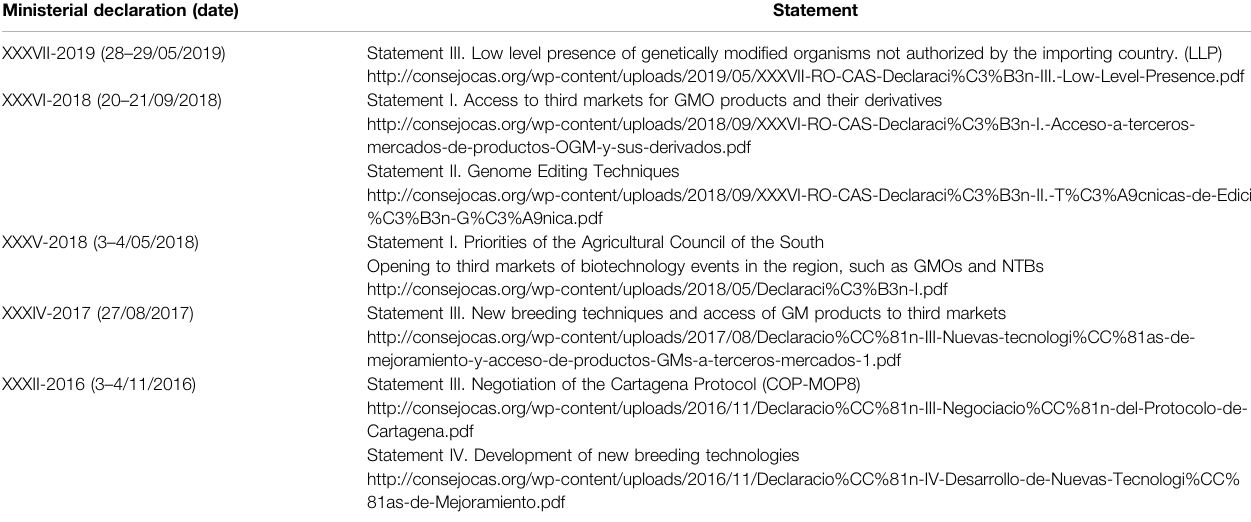
TABLE 1 | Some statements issued by